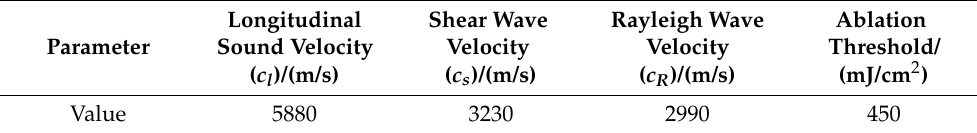
Figure 2. Sample schematic with six embedded notches. Table 2. The stainless-steel (316L)